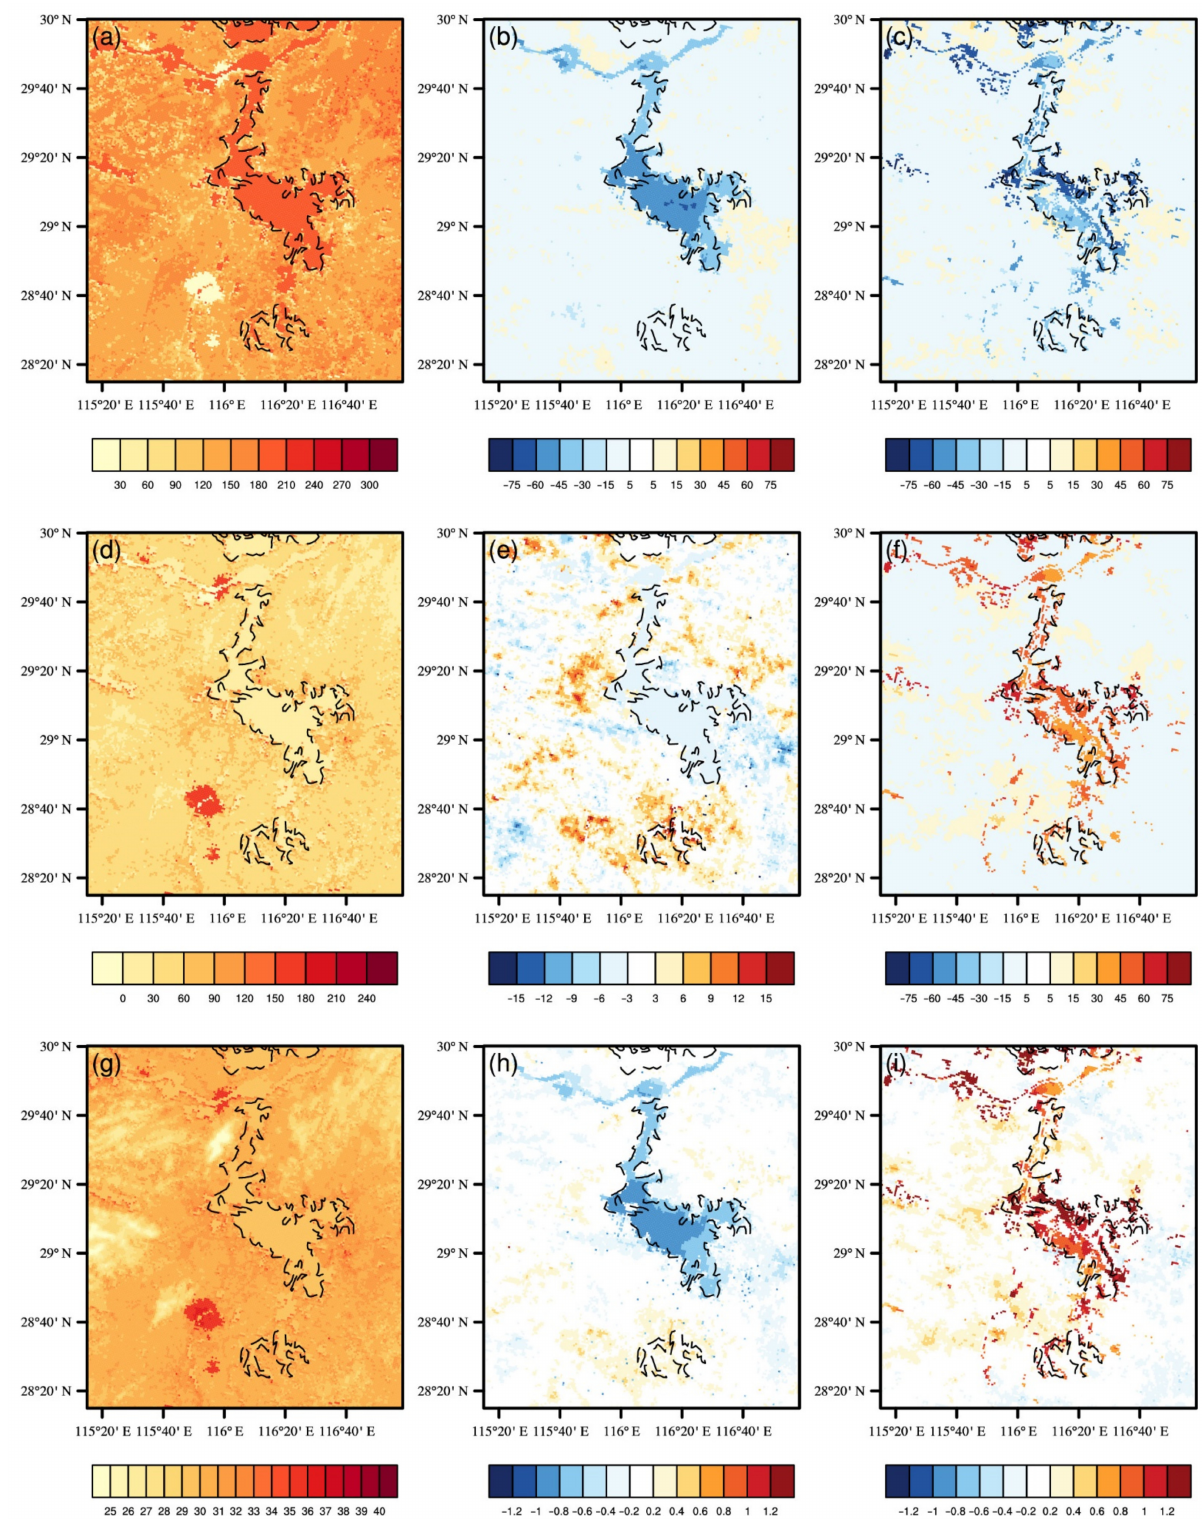
Figure 5. The distribution of the mean ( a – c ) latent heat flux (W m − 2 ), ( d – f ) sensible heat flux (W m − 2 ), and ( g – i ) land surface temperature ( ◦ C) from 1 to 31 July. The control experiment (CTL) is shown in ( a , d , g ). The difference between the CTL and EXPT1 (EXPT1–CTL) is shown in ( b , e , h ). The difference between the CTL and EXPT2 (EXPT2–CTL) is shown in ( c , f , i ). The black dashed line maps the Poyang Lake area in the